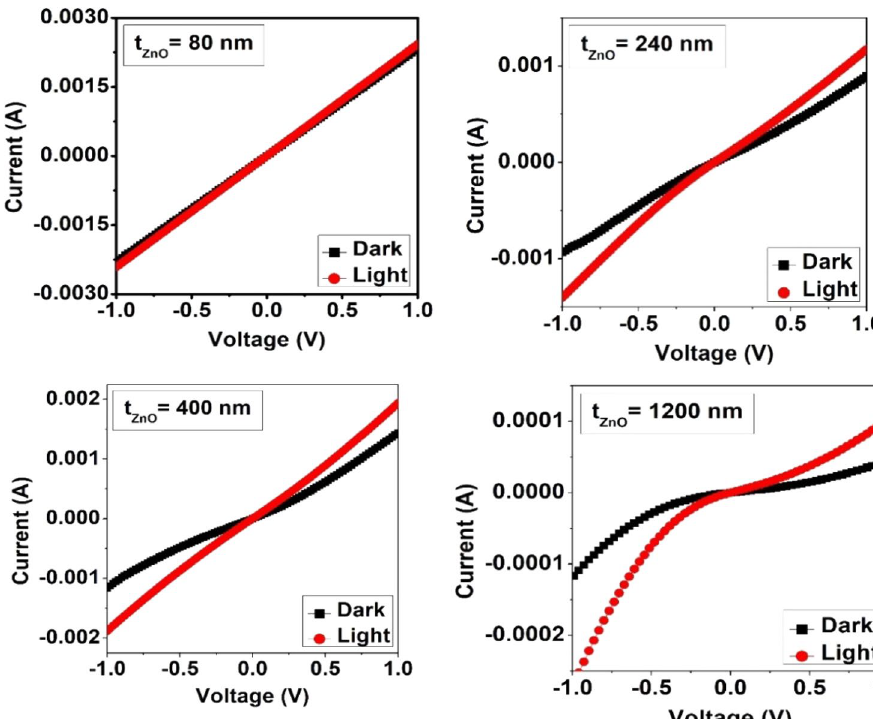
Fig. 5 I-V characteristics of ZnO thin films deposited at different t under dark and ZnO light conditions